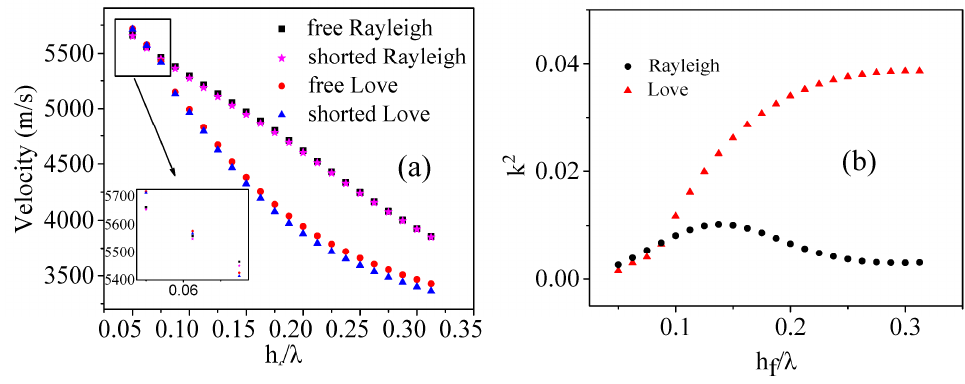
Figure 4. Velocity and electromechanical coupling coefficient of Rayleigh and Love waves vs thickness of ZnO film: ( a ) velocity; ( b ) electromechanical coupling coefficient.